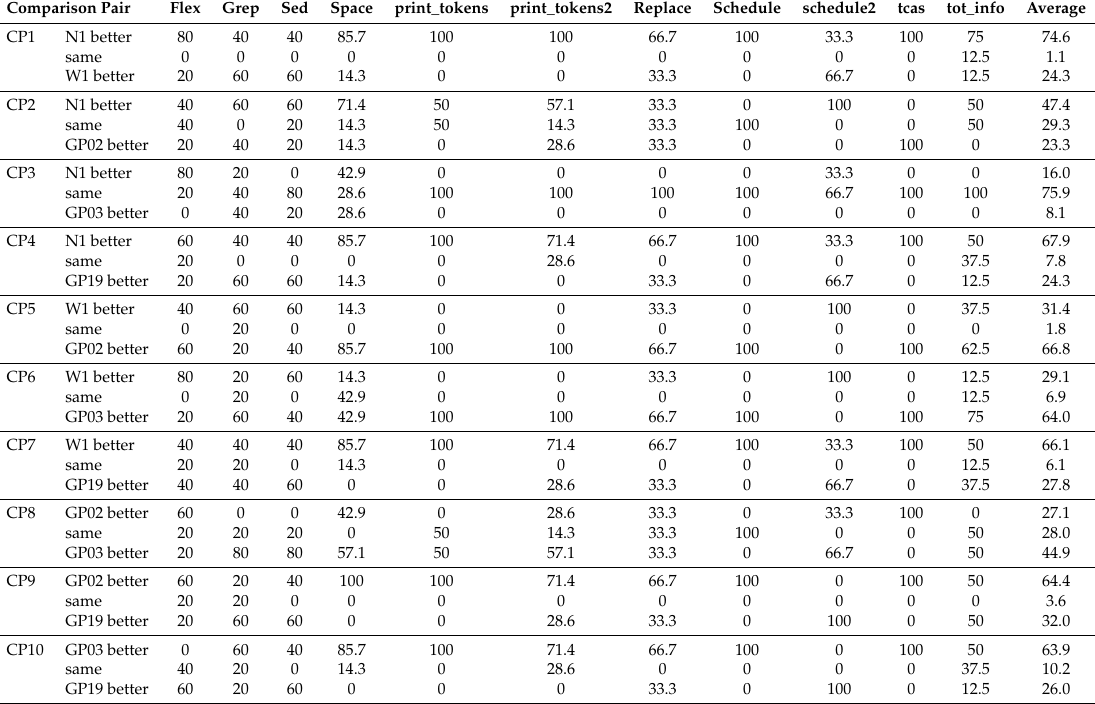
Table 4. Comparison results as percentages of one formula being better than another (%). Comparison